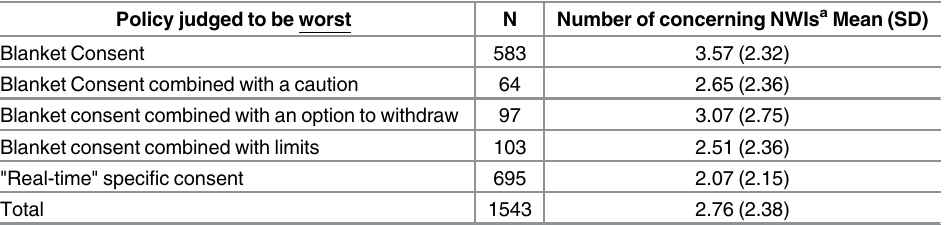
Table 6 examines the effect of the extent of NWI concerns – that is, the number of NWIs where a respondent was unwilling to donate using blanket consent – on policy preferences. An Table 6. Policy preferences by mean number of concerning